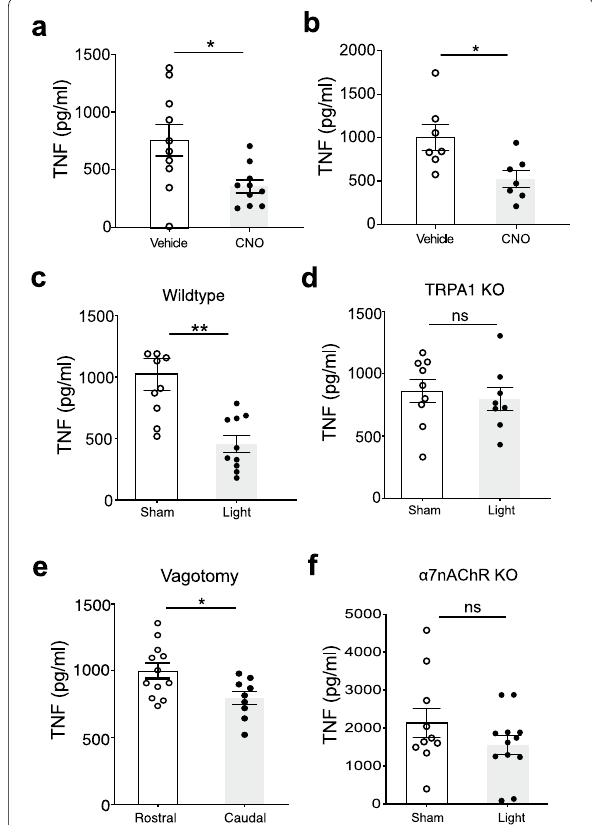
Fig. 5 Activation of vagus nerve TRPA1 signaling inhibits TNF during endotoxemia. a TRPA1-Cre/Gq-DREADD mice were injected with either CNO (5 mg/kg) or vehicle i.p. (n 10/ group) 1 h prior to LPS = (0.3 mg/kg, i.p.). For all endotoxemia experiments, serum TNF levels were analyzed at 90 min post-LPS. Individual mouse data points with mean SEM are presented. Unpaired t-test with Welch’s correction; ± *p < 0.05. b Vehicle or 10 µL CNO (0.25 mg/kg) was administered directly to the exposed vagus nerve (n 7 per group) in TRPA1-Cre/ = Gq-DREADD mice 2 h prior to LPS (1.0 mg/kg). Individual mouse data points with mean SEM are presented. Unpaired t-test with Welch’s ± correction; *p < 0.05. Optovin was directly applied to the vagus nerve and exposed to sham or 405 nm light stimulation (1000 mA, 10 Hz, with a 10% duty cycle for 5 min) 2 h prior to LPS injection. c Wildtype mice (B6.129PF) receiving sham (n 9) or light (n 10) stimulation. = = Unpaired t-test with Welch’s correction; **p < 0.01. d TRPA1 KO mice receiving sham (n 9) or light (n 8) stimulation. Individual mouse = = data points with mean SEM are presented. Unpaired t-test with ± Welch’s correction; ns: not significant. e Vagotomy was performed either rostral (efferent; n 12) or caudal (afferent; n 9) with respect = = to optovin administration site in wildtype mice (B6.129PF) and subjected to sham or 405 nm light stimulation 2 h prior to endotoxin injection. Individual mouse data points with mean SEM are ± presented. Unpaired t-test with Welch’s correction; *p < 0.05. f Vagus nerve was exposed in α7nAChR KO mice and optovin was directly applied, and subjected to 405 nm light (n 12) or sham stimulation = (n 10) 2 h prior to LPS injection. Individual mouse data points with = mean SEM are presented. Unpaired t-test with Welch’s correction; ± ns: not